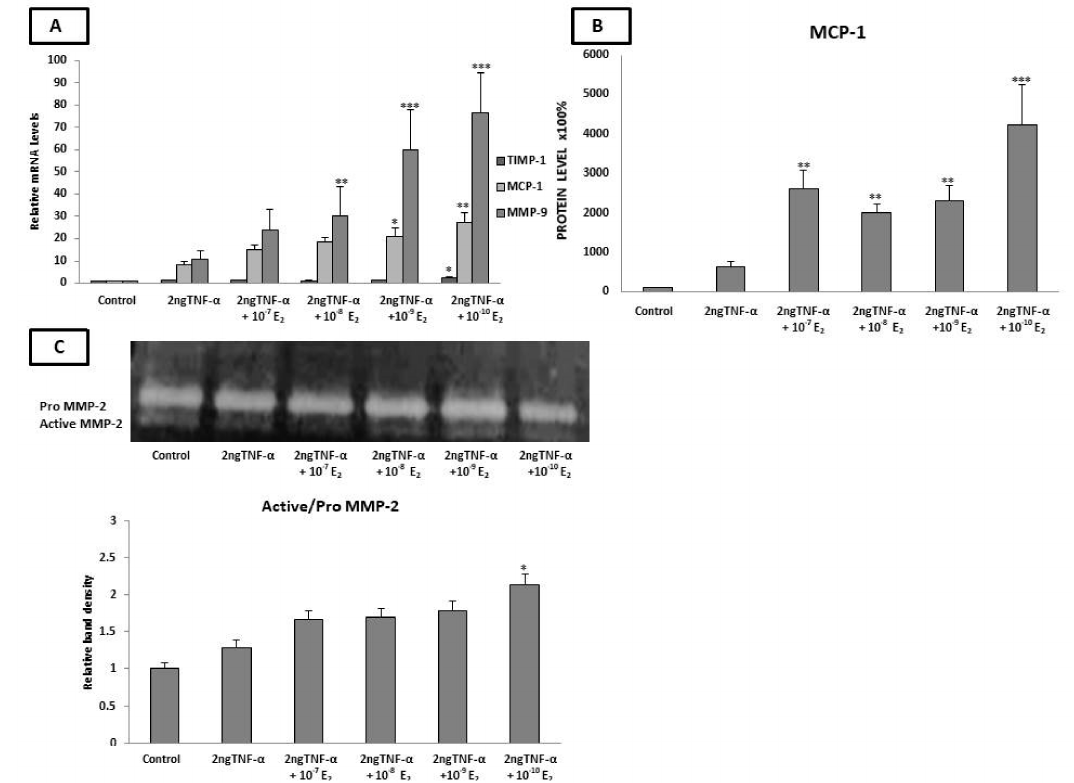
Figure 2. Effects of the pre-incubation of HAECs with 2 ng TNF- α followed by co-incubation of the cells with E 2 on the expression of genes and protein involved in plaque stability, as well as on MMP-2 gelatinase activity. ( A ) Pre-incubation of HAECs with 2 ng/mL TNF- α for 24 h followed by co-the incubation of cells with 10 − 10 –10 − 7 M E 2 for a further 24 h significantly increased the expression of TIMP-1, MCP-1, and MMP-9, as compared to cells incubated with TNF- α alone. ( B ) Pre-incubation of HAECs with 2 ng/mL TNF- α for 24 h followed by the co-incubation of cells with 10 − 10 –10 − 7 M E 2 for a further 24 h significantly increased the MCP-1 protein levels as compared to cells incubated with TNF- α alone. ( C ). The ratio of active MMP-2/pro-MMP-2 was significantly increased after 24 h incubation with 2 ng/mL TNF- α followed by the co-incubation of cells with 10 − 10 E 2 . The graphical data are represented as mean ± SD of at least three independent experiments (*** p < 0.001, ** p < 0.01, * p <